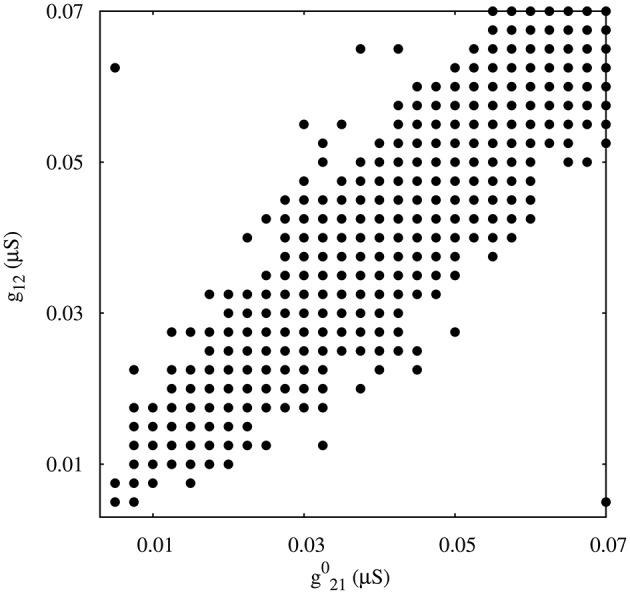
Map of conductances g12 and g21 that lead to regularization of the spiking-bursting activity for the connection topology with fast symmetric temporal dynamics. The incremental step for both g12 and g21 is 0.0025 μS. Black circles represent values that lead to regular activity (Cv < 5%). The symmetric distribution of the circles in the map reflects the balanced temporal dynamics of the fast synapses, which in general allows only moderate differences in the maximal conductances to achieve regularity.